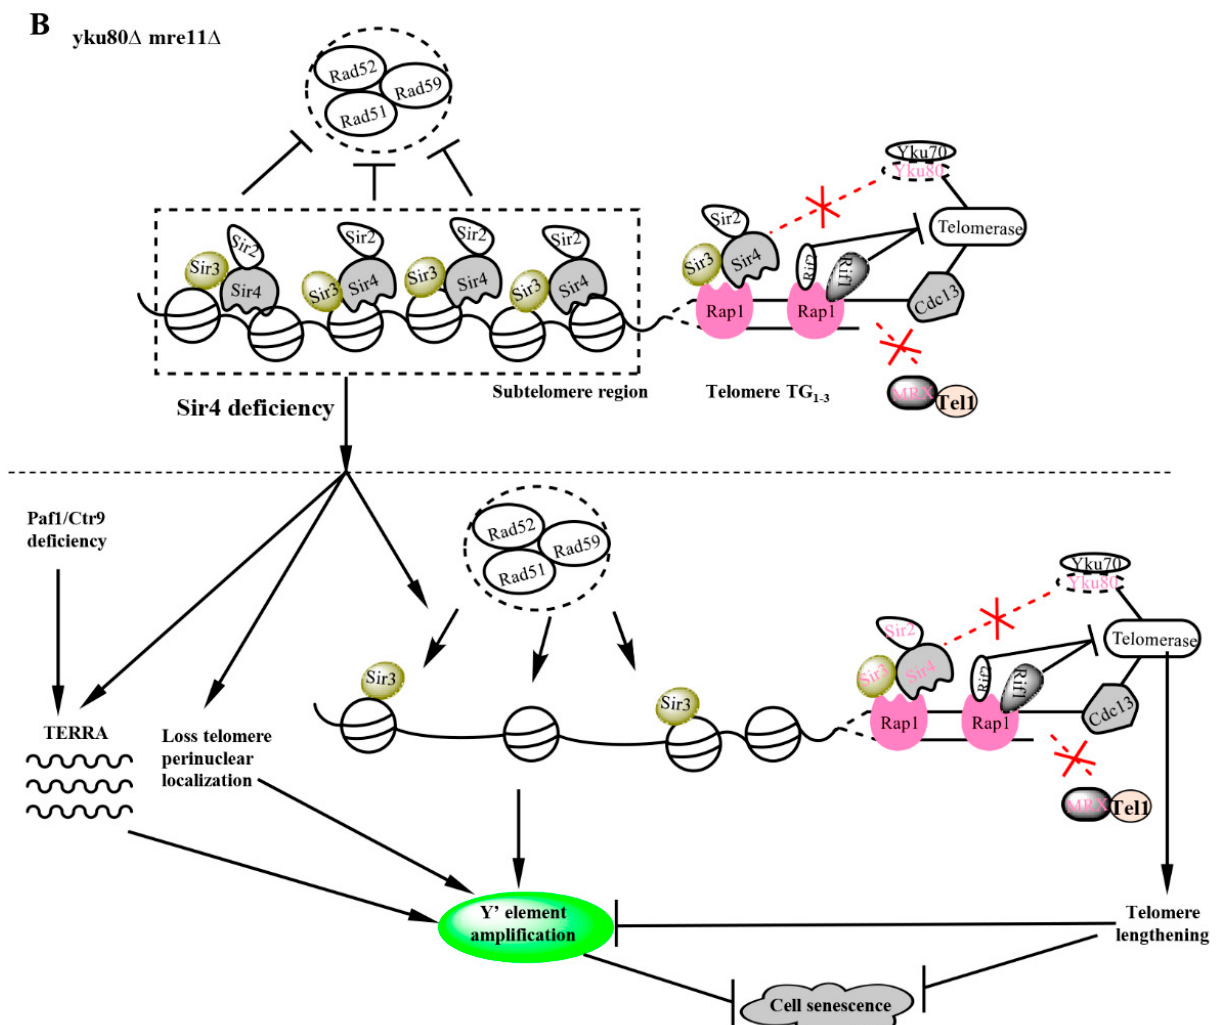
Figure 6. Schematic showing the roles of Sir3/4 and Rif1/2 and their relationships to the up- and down-stream elements in the rescuing pathway of senescence induced by Yku80 and Mre11 deficits. ( A ) Summary of effects of Sir3/4 and Rif1/2 on sub-telomere Y (cid:48) element amplification and senescence of yku80 ∆ mre11 ∆ cells, a telomerase-positive sub-telomere-recombination model. ( B ) A schematic picture showing the molecular roles of Rap1, Sir2/3/4, Yku80/Yku70, Rif1/2, Yku80, Mre11, Tel1, Rad52/Rad51/Rad59, telomerase, Cdc13 at sub-telomere and telomere ends. yku80 ∆ mre11 ∆ cells define a telomerase-positive sub-telomere-recombination model, following cell divisions, their telomeres do not reach critical short length but very short, some cells go through senescence characterized with reduced cell numbers during subculturing and sub-telomere Y (cid:48) element amplification, which might be due to disrupted Sir4-Yku80-Tlc1 telomerase-recruitment pathway and Rif1/2-inhibited-MRX-mediated ssDNA generation for Cdc13 loading, and pervasive action of exonuclease Exo I at telomere ends. Sir4 deficiency increases Y (cid:48) element amplification frequency and rescues the senescence of yku80 ∆ mre11 ∆ cells by disrupting telomere perinuclear localization, loss of telomere heterochromatin structure, and increasing TERRA transcription. In parallel, Paf1 or Ctr9 deficiency increases TERRA transcription in a Sir4-independent manner, but interestingly, further increases Y (cid:48) element amplification in sir4 ∆ cells. Sir4 deficiency results in changes of sub-telomere structures that might have increased the access of Rad51/Rad52/Rad59 complex mediated machinery into sub-telomere region to promote Y (cid:48) element amplification.